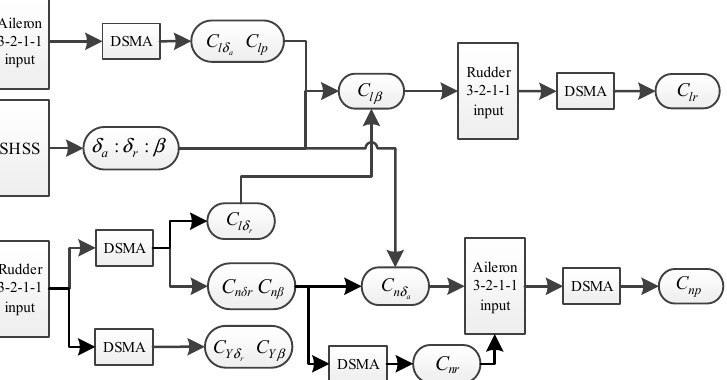
Figure 4. Identification procedure of lateral-directional aerodynamic parameters.